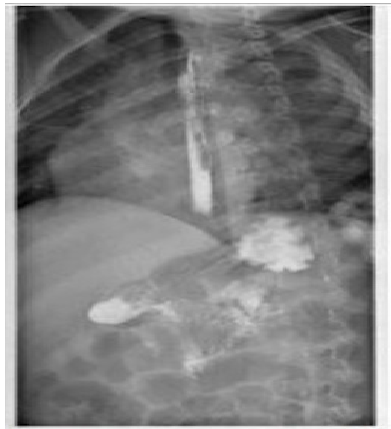
Figure 4. Esophagram demonstrating irregularity in the middle esophagus, with no extravasation of fluid.